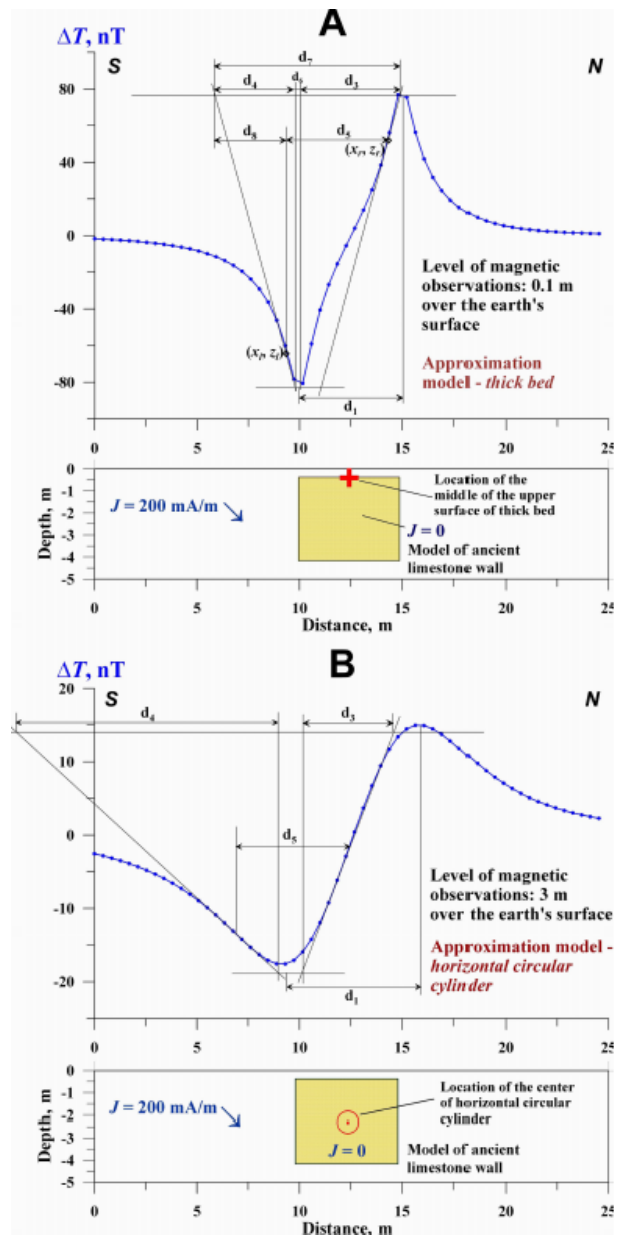
Fig. 10. Realization of two-level observations with two different interpretation models utilized: (A) model of a thick bed, (B) model of the horizontal circular cylinder. Magnetization is denoted as J